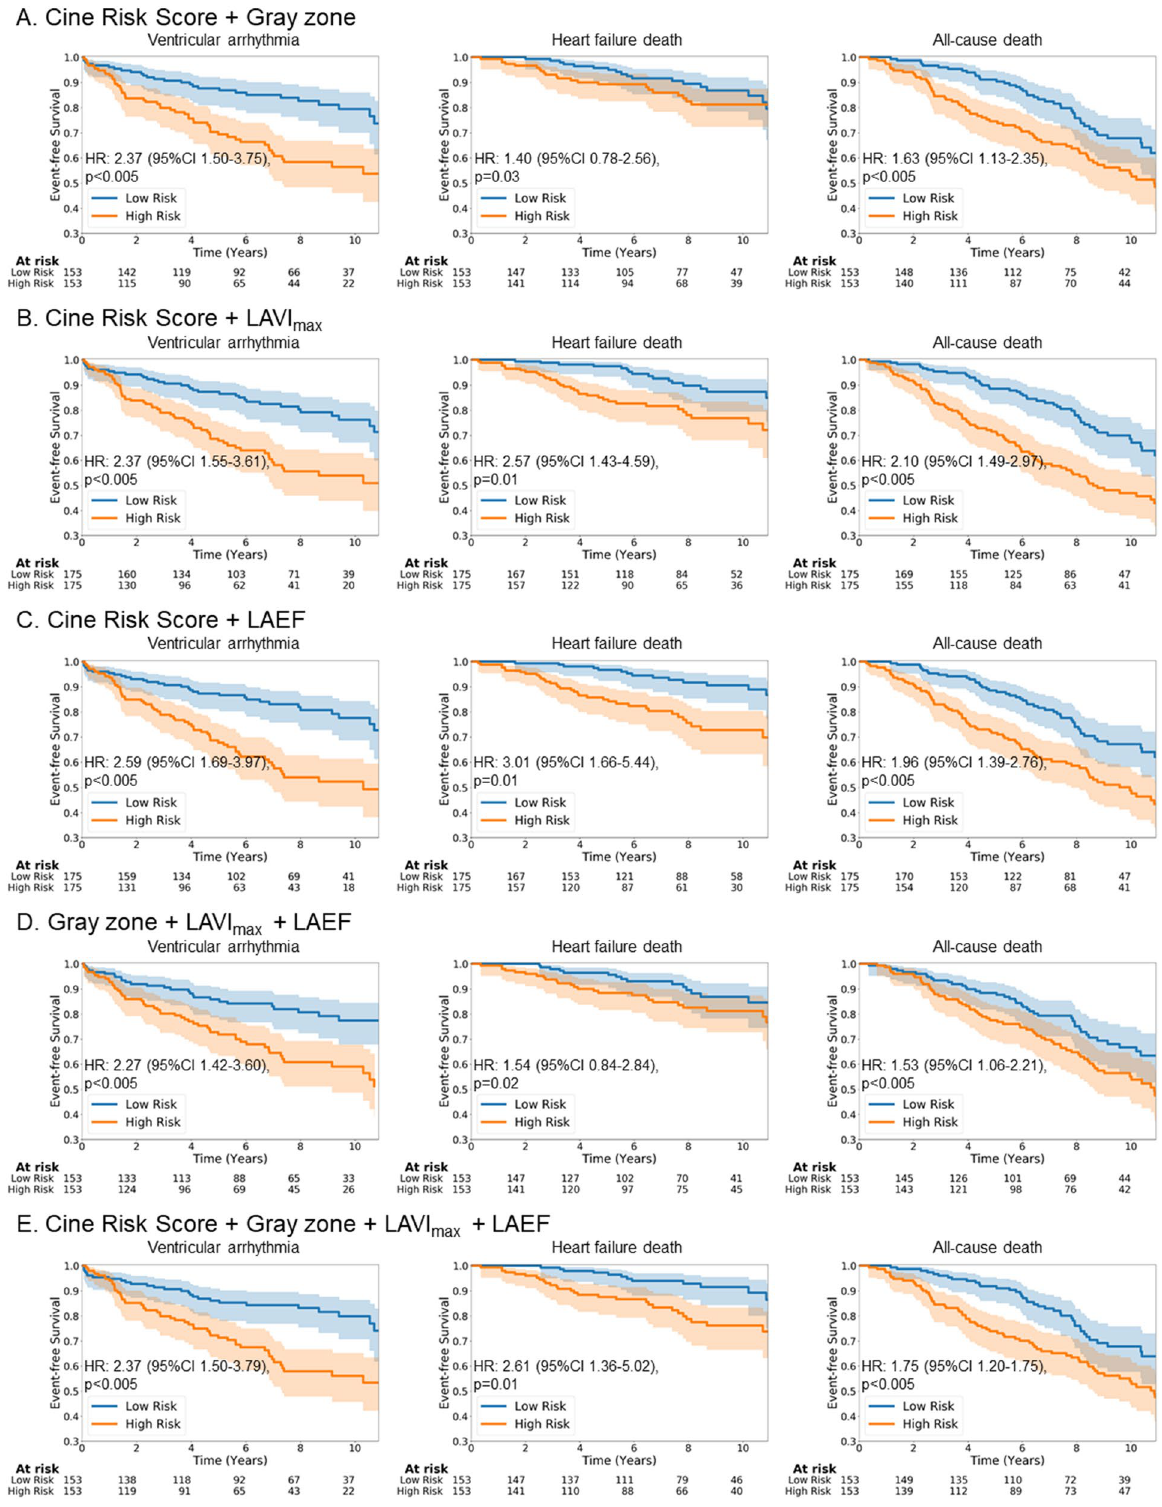
Figure 3. Survival prediction for each endpoint using multivariate Cox Proportional Hazards Regression models. ( A ) Cine risk score + LV LGE gray zone. ( B ) Cine risk score + LA maximum volume index. ( C ) Cine risk score + LA total emptying fraction. ( D ) LV LGE gray zone + LA maximum volume index + LA total emptying fraction. ( E ) Cine risk score + LV LGE gray zone + LA maximum volume index + LA total emptying fraction. The shaded area represents 95% confidence